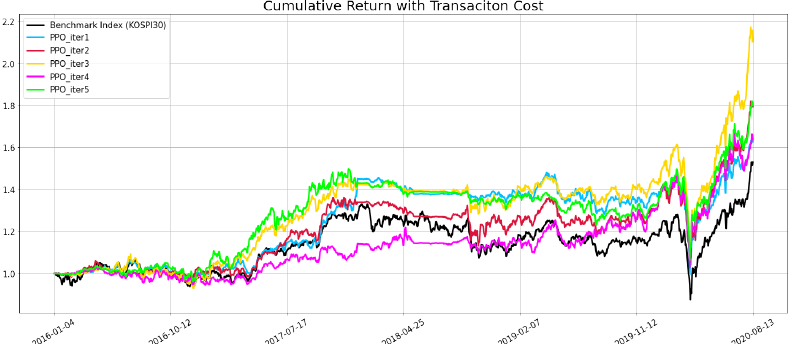
Figure 7. Cumulative return curves of PPO agent and KOSPI30 ( h max = 10, buying threshold = 3, selling threshold = 0, initial portfolio value 1,000,000,000, from 4 January 2016 to 13 August 2020 (1134 days)).